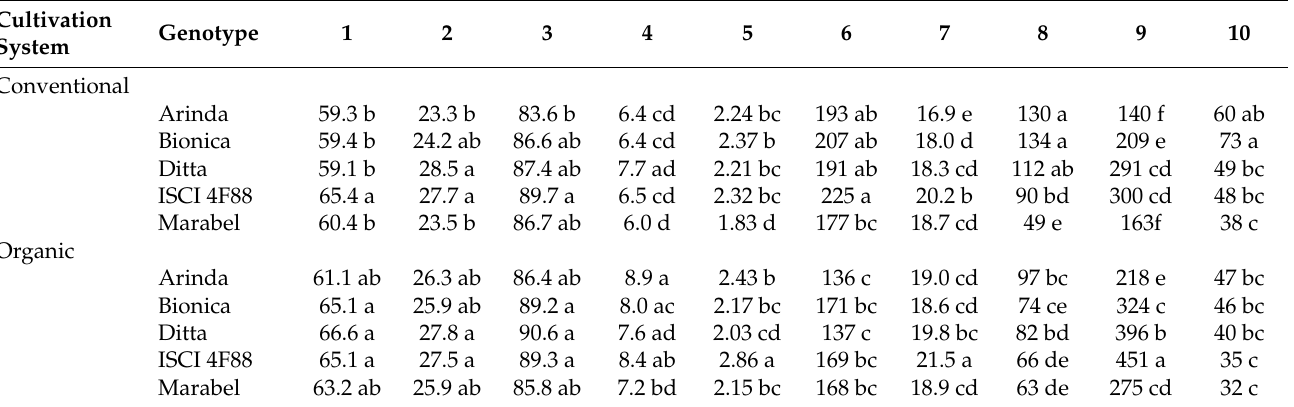
Table 5. Physico-chemical and nutritional quality of early potatoes as affected by ‘cultivation system × genotype’